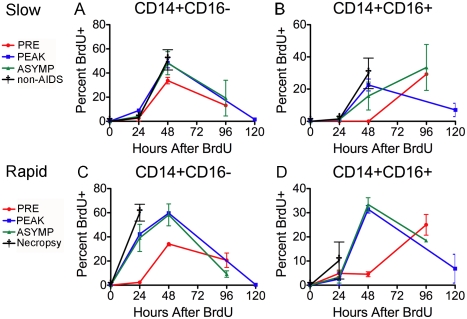
Monocyte subsets leave the bone marrow at different rates that are accelerated in animals that develop SIVE.BrdU was injected four times over the course of the study. Red = pre-infection (days −10 days post infection (dpi)), Blue = peak infection (7 dpi), Green = “asymptomatic” period (26 dpi) and Black = 88 dpi (slow progressors = A–B) or necropsy (rapid progressors = C–D). BrdU injections were given at 24hrs before necropsy. The percentage of BrdU+ monocytes in each subset was determined 24hr and 48hr and either 96 or 120 hrs after BrdU injection (Time: 0 hr). (A–B) Dots represent the averages of the percentage of BrdU+ cells in the subsets of slow progressors that remained asymptomatic throughout the period examined. A. There is no change in the percentage of BrdU+ CD14+CD16− cells between pre- and post-infection time points. B. There is a slight increase in the percentage of BrdU+ CD14+CD16+cells after infection that is apparent at 48hrs. (C–D) Dots are averages from two rapid progressors (244-96 and 55-05). The percentage of BrdU+ monocytes was only examined 24hrs after BrdU pulse for animals, DB79 and CM07. C. The difference in the percentage of BrdU+CD14+CD16− cells between pre- and post-infection is apparent at 24hrs. D. The difference in the percentage of BrdU+ CD14+CD16+cells between pre- and post-infection occurs at 48hrs. The error in all graphs is the standard error of the mean.